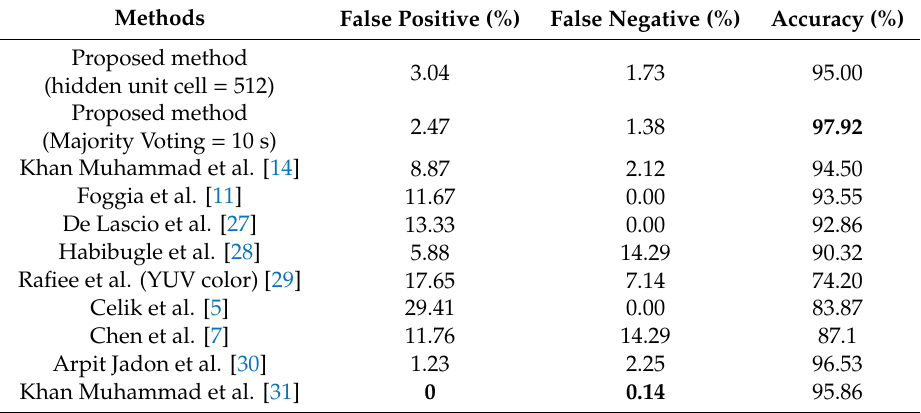
Table 6. Performance comparison with other methods.